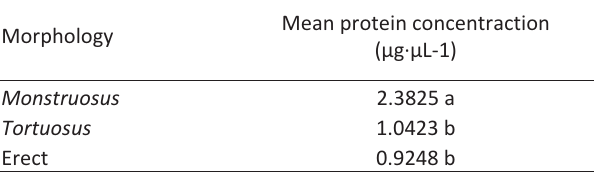
Table 4 ­ Mean protein concentrations (µg µL ­1 ) from the three Cereus morphologies (erect, tortuosus and monstruo‐